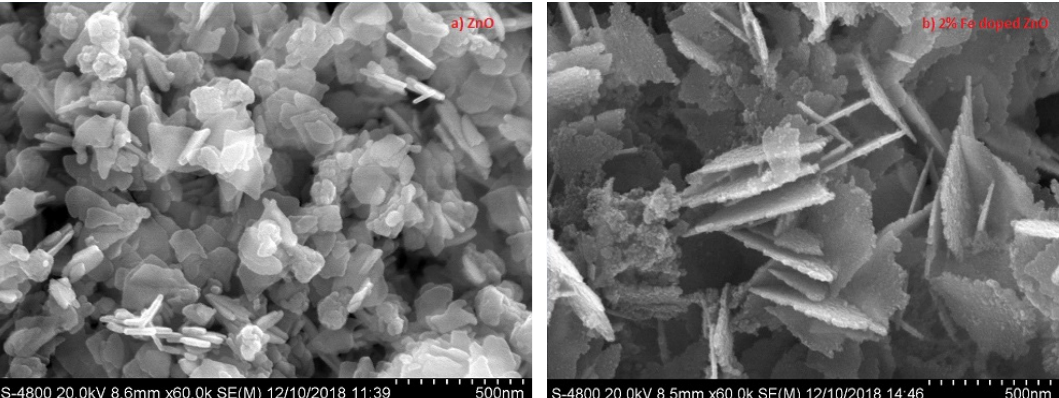
Fig. 5. SEM images of a) ZnO and b) 2% Fe-ZnO nanomaterials Fig.5. SEM images of a) ZnO and b) 2% Fe-ZnO nanomaterials